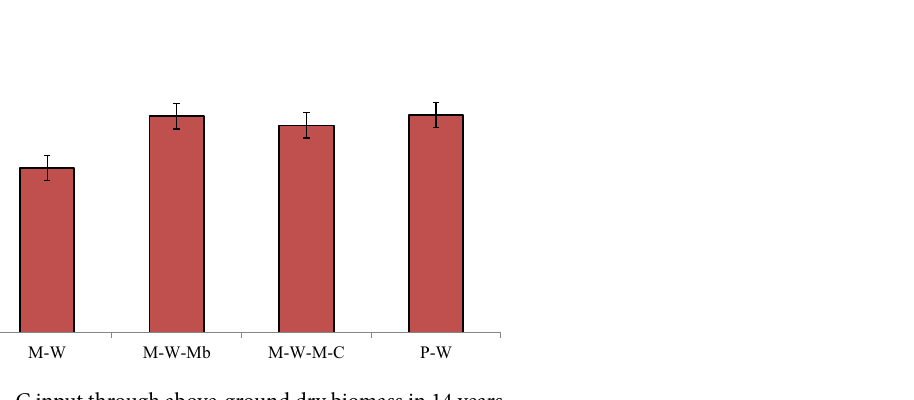
Figure 4. C input through above-ground dry biomass in 14